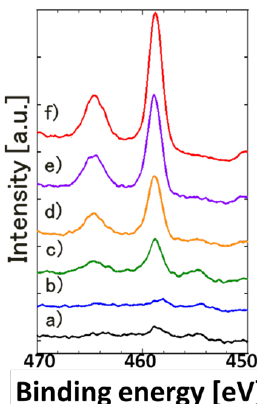
Figure 5. Ti 2p XPS spectra of Ti-DLC films before and after exposure to atomic oxygen. Fluences of atomic oxygen beam are ( a ) 0 atoms cm −2 , ( b ) 1.2 × 10 17 atoms cm −2 , ( c ) 1.2 × 10 18 atoms cm −2 , ( d ) 3.5 × 10 18 atoms cm −2 , ( e ) 1.2 × 10 19 atoms cm −2 , and ( f ) 1.9 × 10 20 atoms cm −2 . Table 1. Elementary composition of Ti-DLC films before and after exposure to atomic oxygen. Fluence C O Ti atoms·cm −2 at.% 0 79 18 3 1.16 × 10